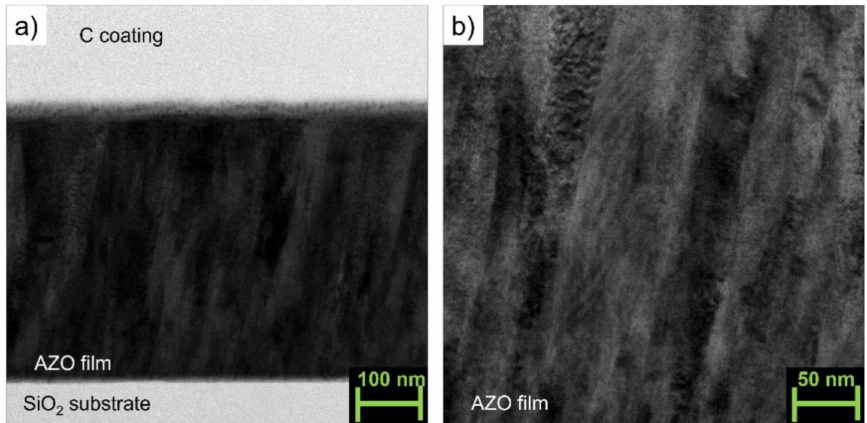
Figure 2. ( a ) Cross-sectional transmission electron microscope (TEM) image (magnification 150,000) of the AZO/silica thin film AZO_0S; ( b ) double magnification (300,000 × ) taken in the central zone of Figure